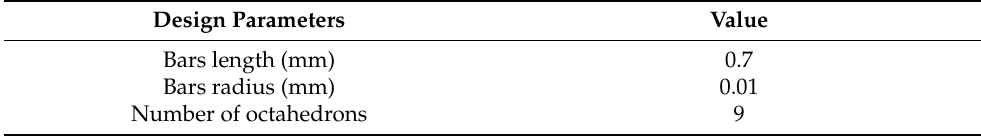
Table 2. Design parameters used for second scale